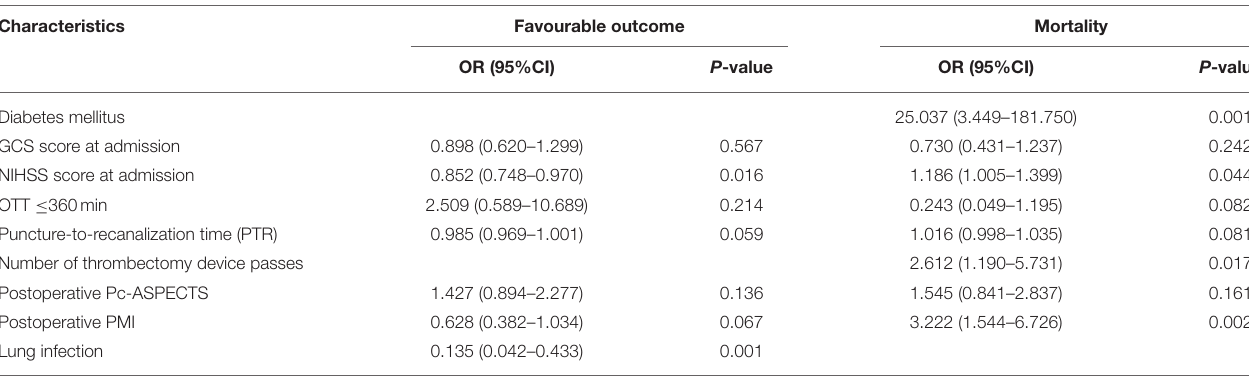
TABLE 5 | Multifactor logistic regression for functional outcome and